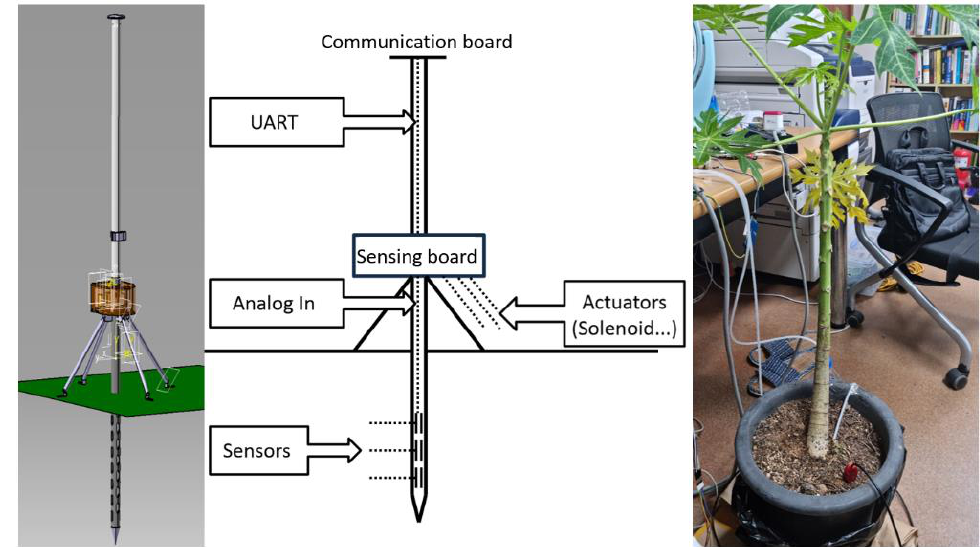
Figure 1. Smart farm stick and plant used in test.